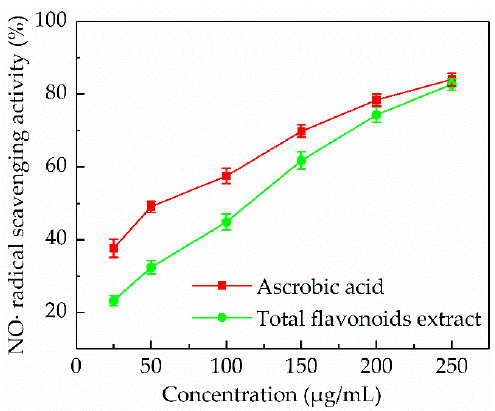
Figure 6. NO• radical scavenging activity of the P. cretica extract obtained by optimized ultrasound- assisted compared with ascorbic acid.